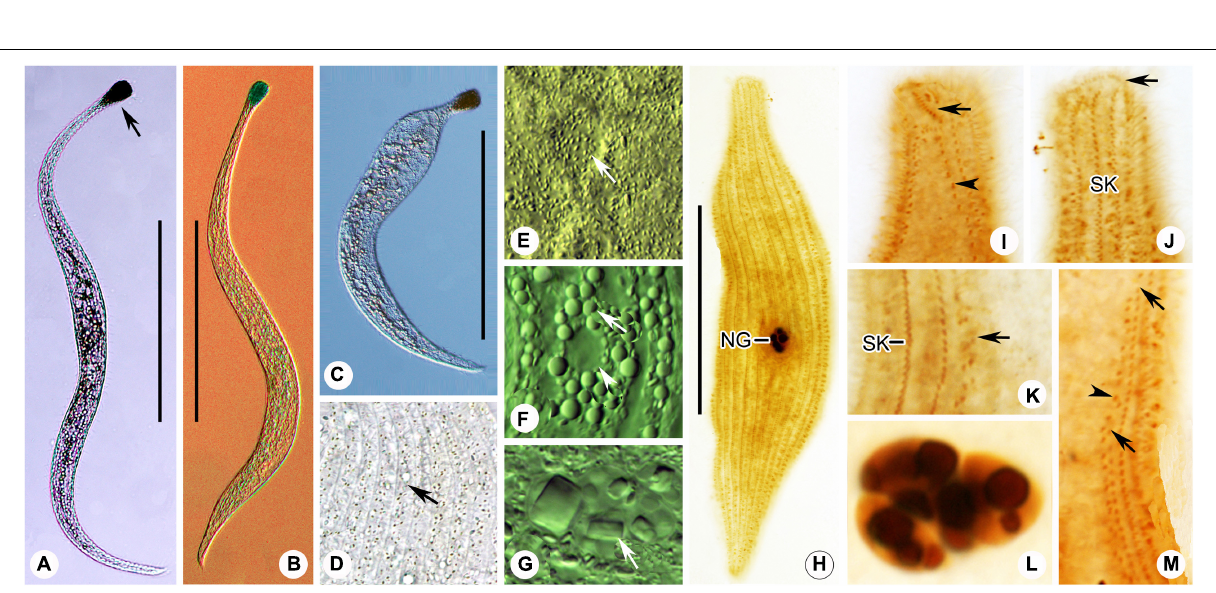
FIGURE 7 | (A–M) Tracheloraphis katzae spec. nov. in vivo (A–G) and after protargol staining (H–M) . (A–C) Typical individual. Arrow showing the head of the cell. (D) Distribution of cortical granules (arrow) between somatic kineties. (E) Distribution of cortical granules in glabrous stripe (arrow). (F) Arrow showing globular granules in cell. Arrowhead showing a vacuole. (G) Nuclear group. Arrow showing crystals in the macronuclei. (H) Right view of the holotype specimen showing the ciliary pattern and multiple macronuclei. (I,J) Detailed ciliature of left (I) and right (J) side of anterior body region. Arrow in I shows brosse, arrowhead showing bristle kinety. Arrow in (J) showing circumoral kinety. (K) Arrow showing somatic kineties. (L) Nuclear group. (M) Arrows showing secant system on left side of glabrous stripe. Arrowhead showing bristle kinety. NG, nuclear group; SK, somatic kineties. Scale bars = 200 µ m (A–C) ; 70 µ m (H)